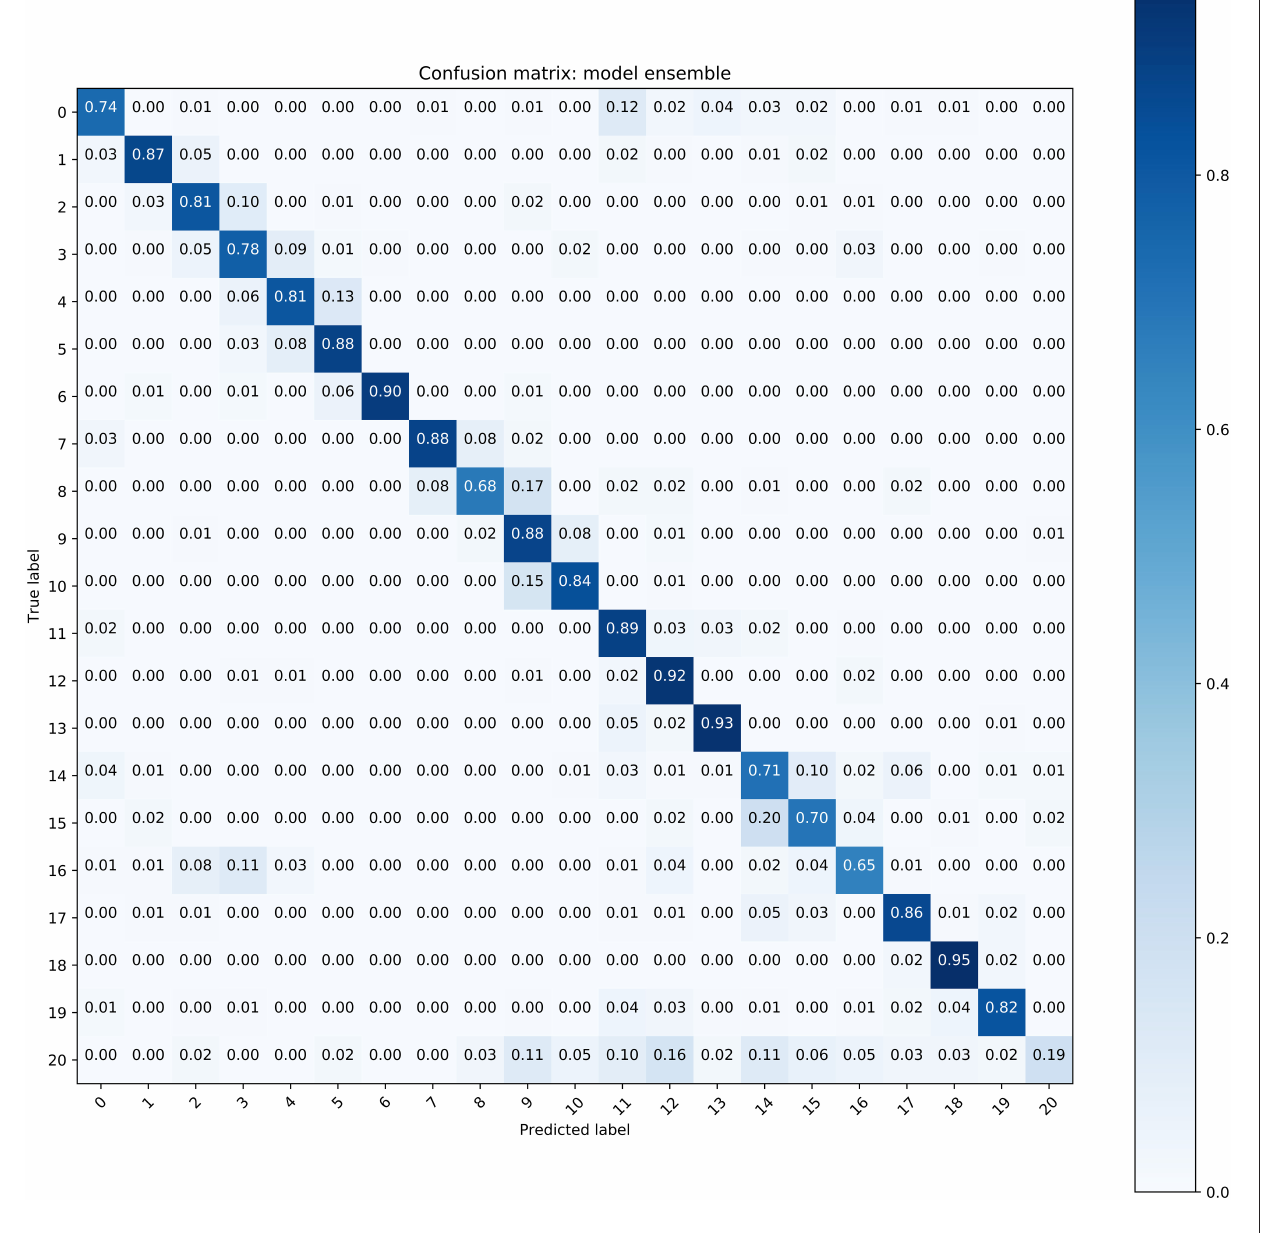
FIGURE 5 | The confusion matrix of the ensemble model for WBC classification (Refer to Table 1 for cell types of each class).